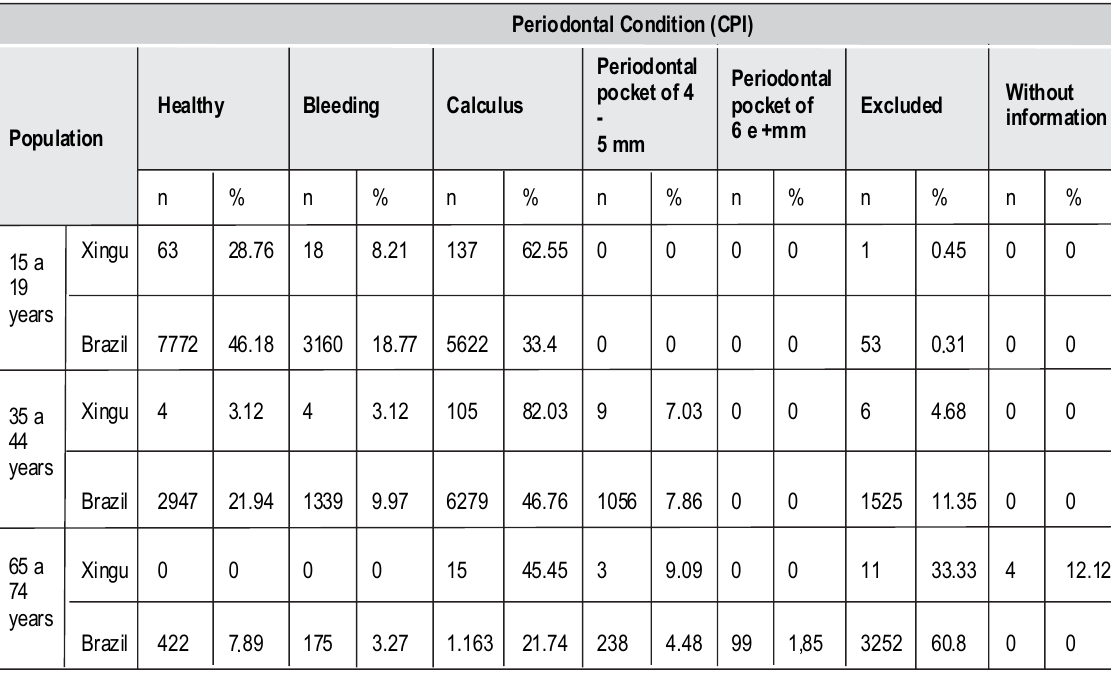
Table 1- Number and percentage of people, according to the highest degree of periodontal condition observed in the individual, age and population of study. Brazil (2004) 4 and Middle and Lower Xingu,